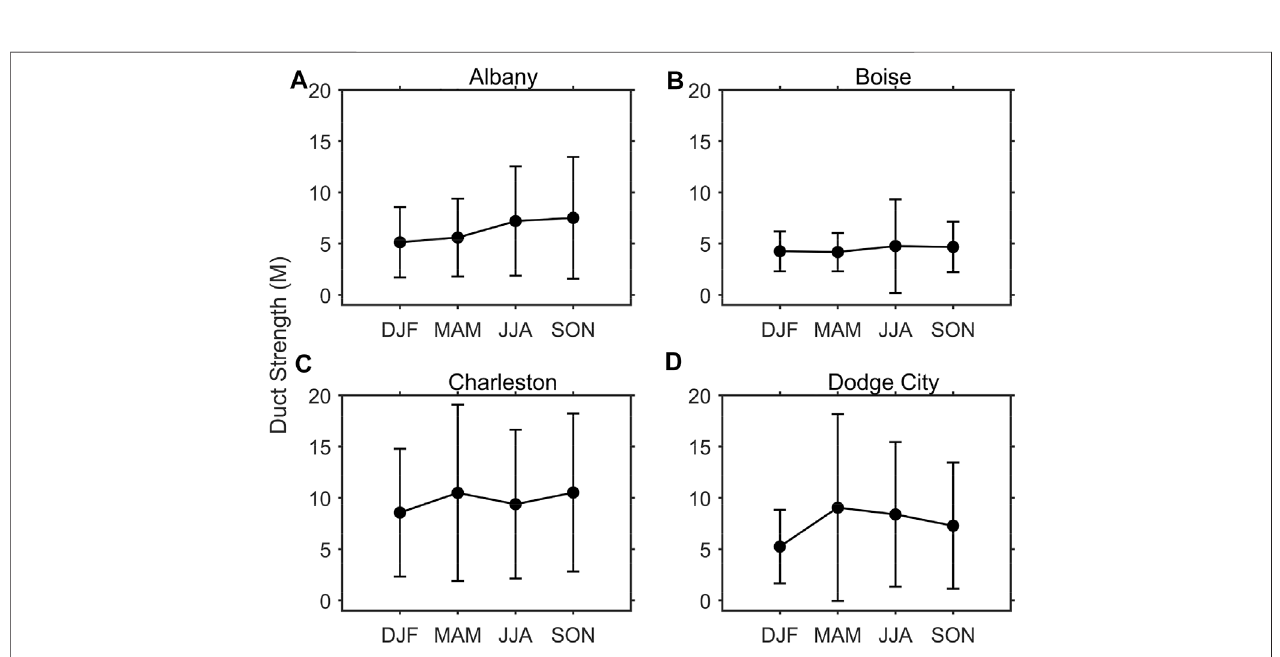
FIGURE 8 | Seasonal variation of the duct strength over the four stations. (A – D) Albany, Boise, Charleston and Dodge City. The vertical bars are the standard errors.